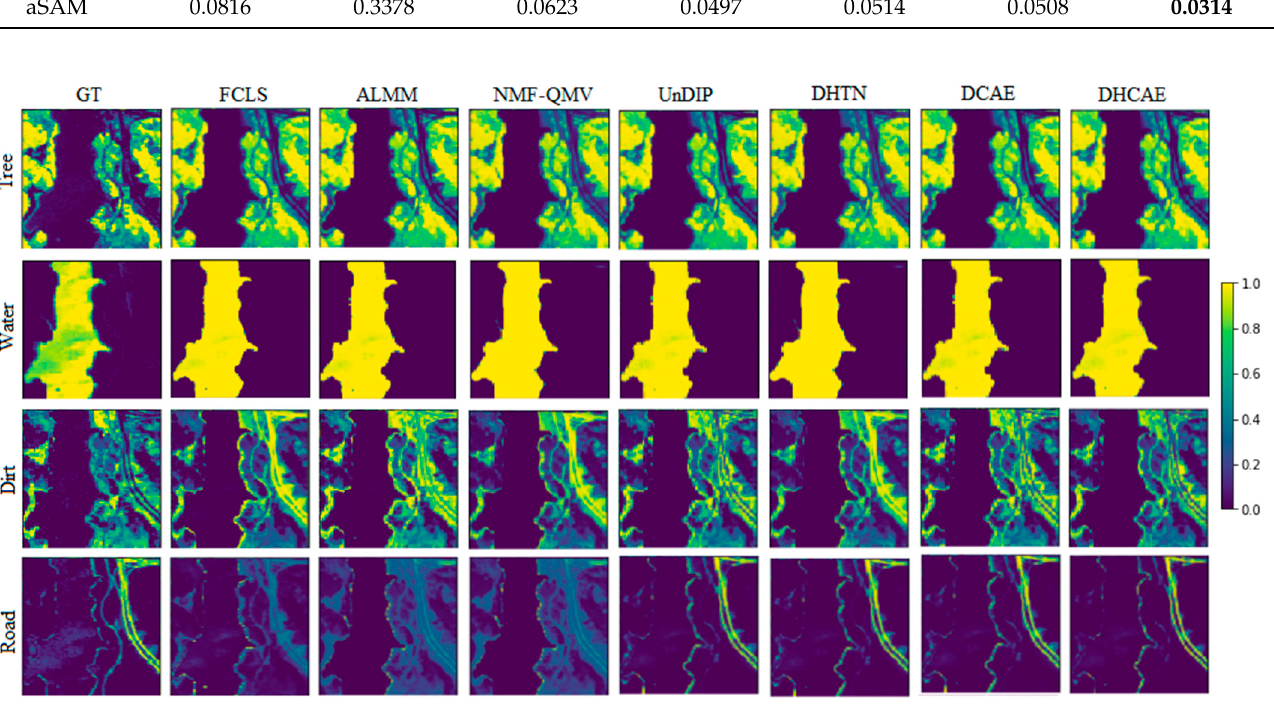
Table 3. Quantitative performance on the Jasper Ridge dataset with noisy bands by various ap-